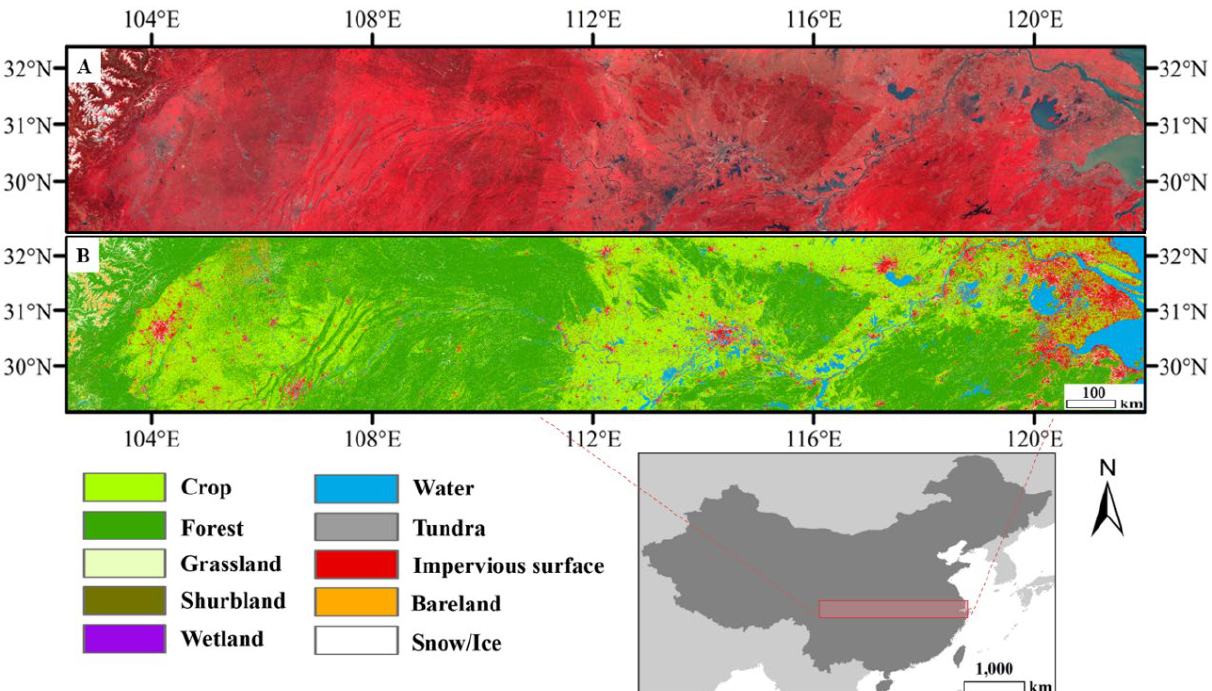
Figure 1. Study area and data with the false-color composite satellite image ( A ) and the classified image ( B ).